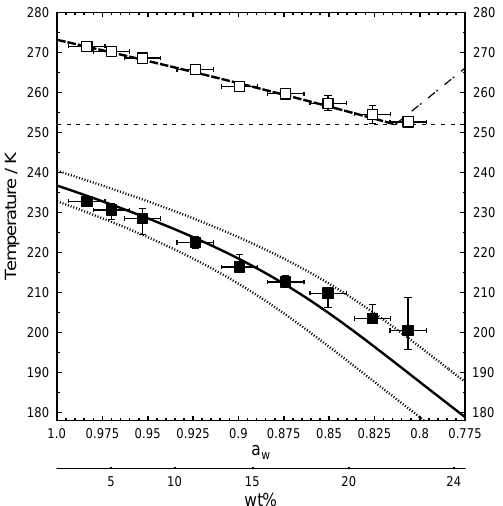
Fig. 1. Median homogeneous freezing temperatures and corre- sponding mean melting temperatures for aqueous NaCl droplets are shown as filled and open squares, respectively, as a function of a w and wt %. The error bars for the freezing temperatures indicate the 10th and 90th percentile and error bars for the melting temper- atures indicate one standard deviation. Uncertainty in a w is ± 0.01. The narrow dashed line represents the ice melting curve (Koop and Zobrist, 2009). The wide dashed line and the dash-dotted lines indi- cate the eutectic temperature and the solid-liquid equilibrium curve of NaCl · 2H 2 O, respectively (Linke, 1965; Clarke and Glew, 1985). The solid line represents the predicted homogeneous freezing curve (Koop and Zobrist, 2009). The two dotted lines represent an uncer- tainty of the homogeneous freezing curve due to an uncertainty in a w of ± 0.025 (Koop, 2004). It is assumed that a w of the aqueous droplets does not change with temperature (Koop et al.,